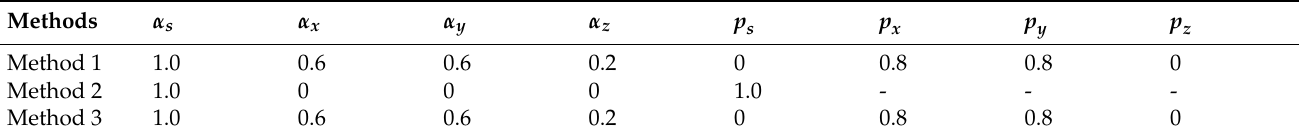
Table 2. Regularization term coefficients and p values for the sparsity